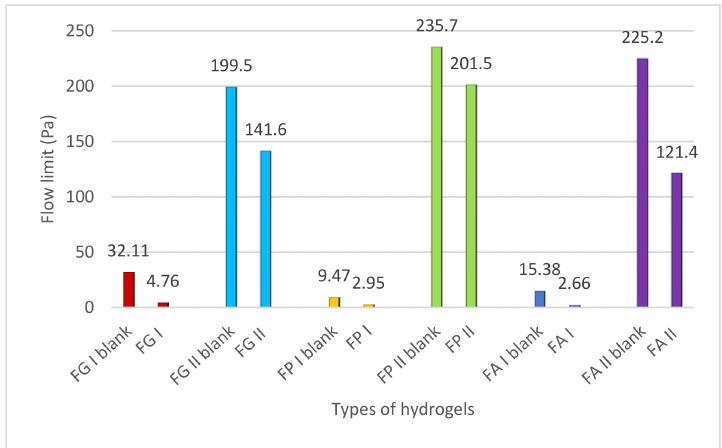
Figure 13. Influence of formulation variables on the yield stress of the studied